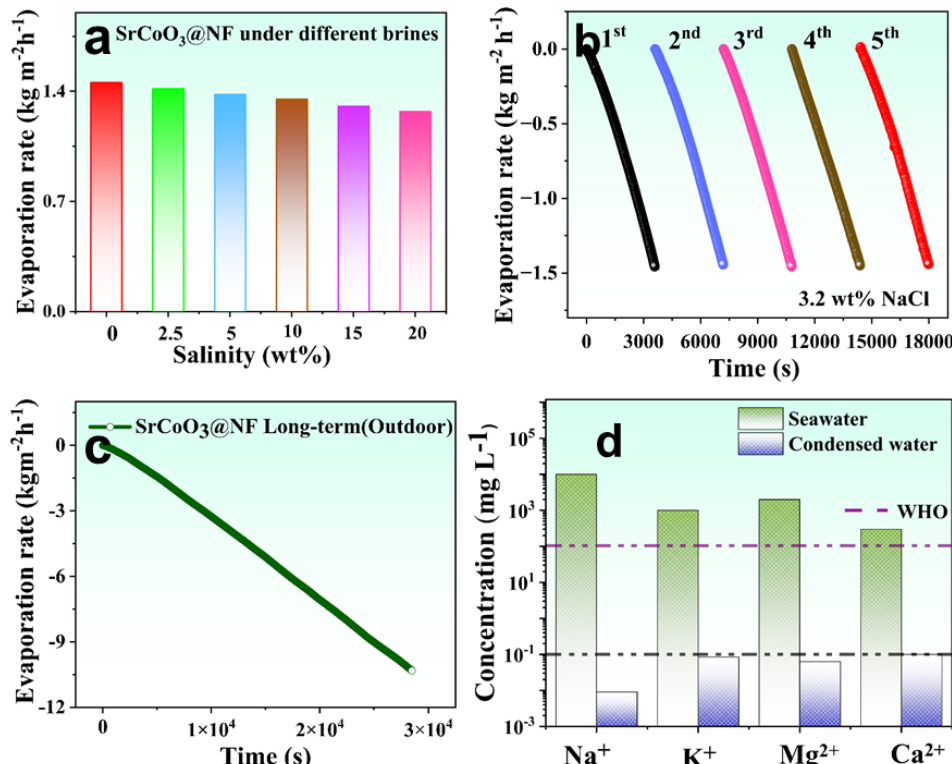
Figure 7. ( a ) Evaporation rates of SrCoO 3 @NF solar evaporator under di ff erent salt concentration solutions. ( b ) Cyclic stability of evaporation rate of SrCoO 3 @NF solar evaporator over 5 consecutive cycles. ( c ) Long-term operational stability of SrCoO 3 @NF solar evaporator for 8 h continuously. ( d )